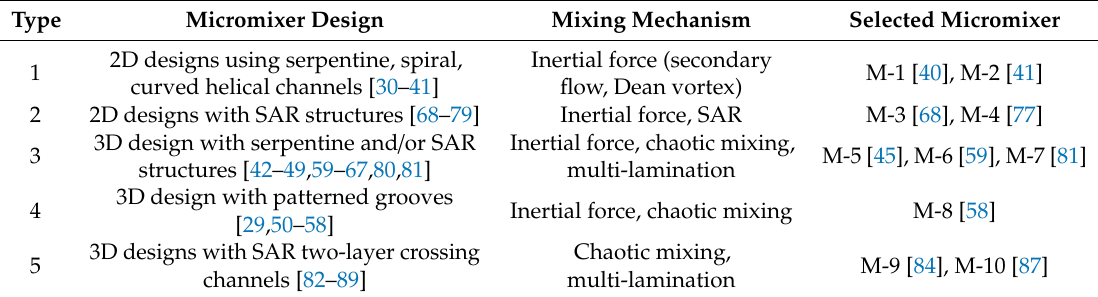
Table 1. Types of micromixer designs.